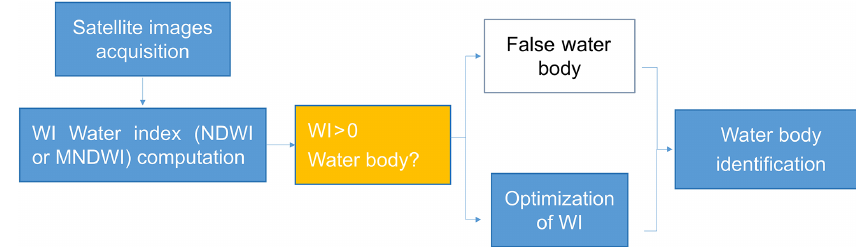
Figure 1. Lake identification procedure by WI. Table 2. Reservoir distribution at irrigation district level. Irrigation district Small reservoirs